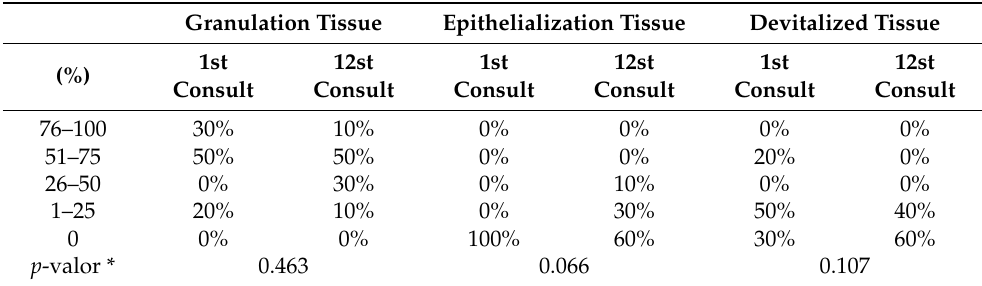
Table 3. The frequency distribution of patients according to the percentage of each tissue type present on the first and twelfth weeks of treatment, N =